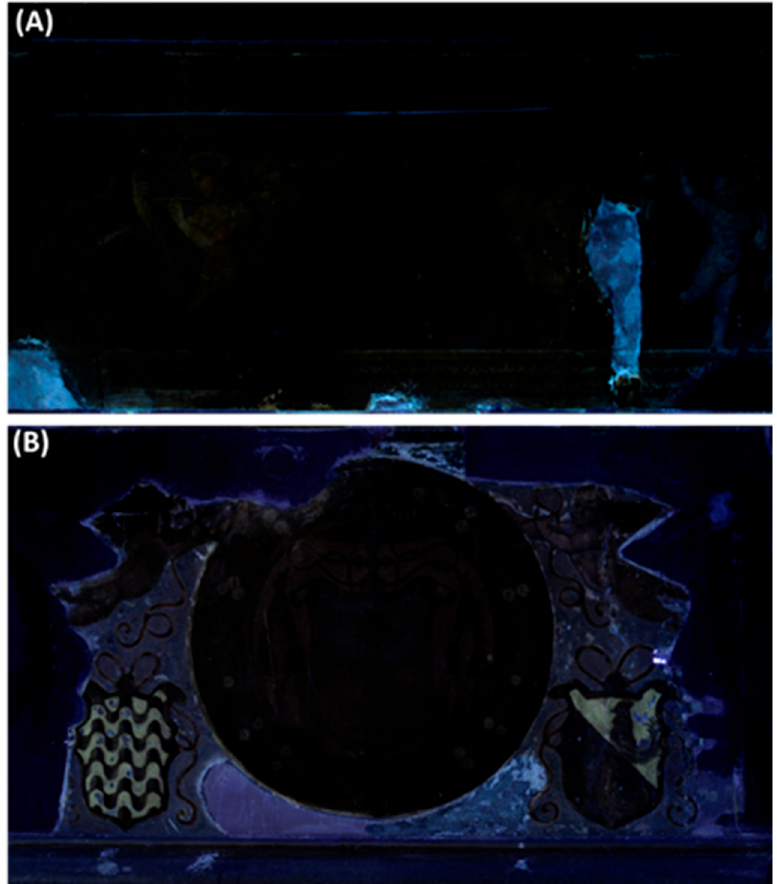
Figure 6. UVF photomosaic of the wall paintings before the restoration. The upper frieze ( A ) and the Riario coat of arms ( B ).